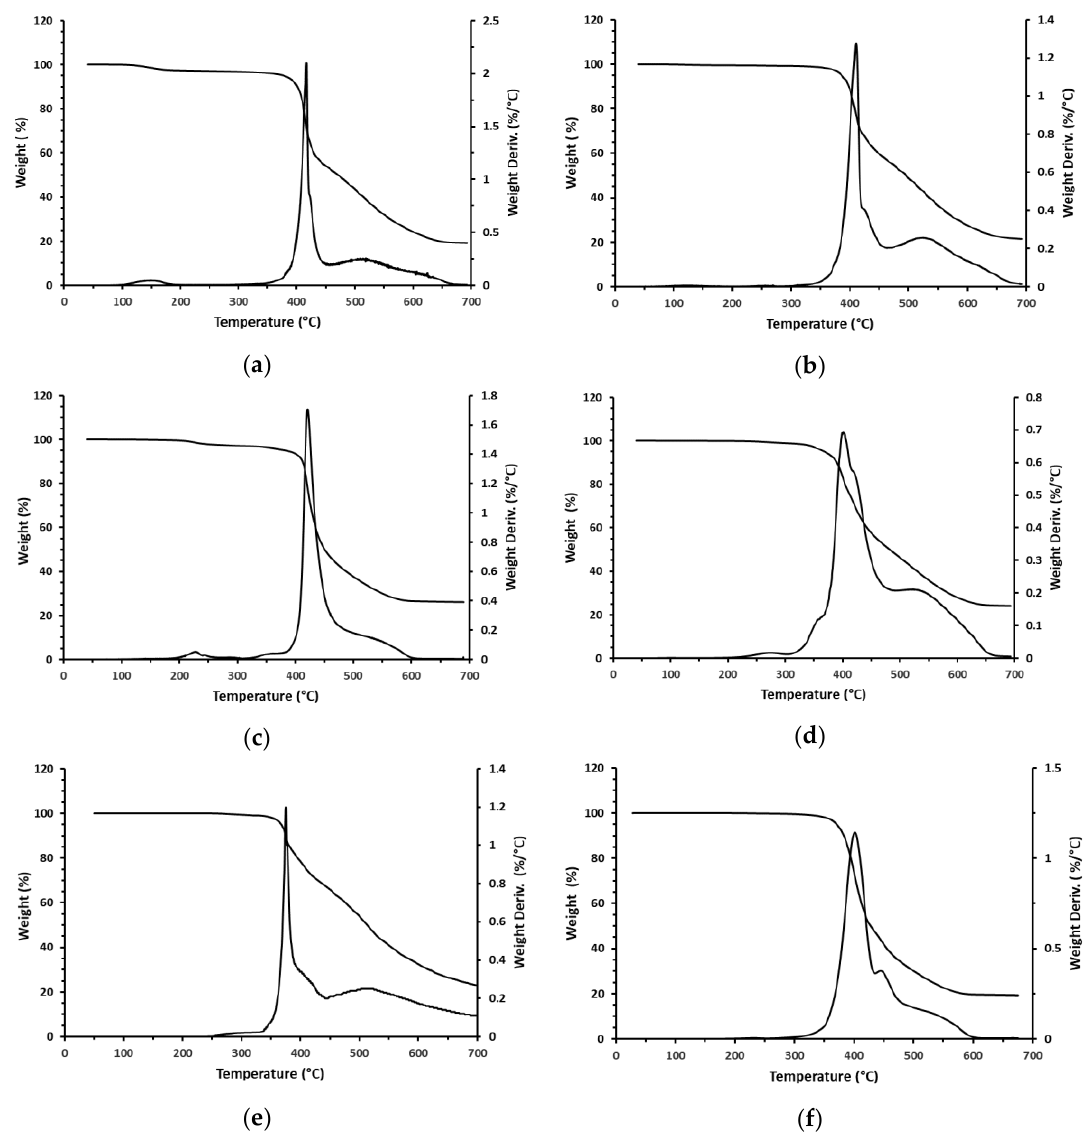
Figure 7. Thermogravimetric weight loss (TGA) and the rate of weight loss (DTG) of brominated flame retardants. ( a ) T-PBBB; ( b ) DBE-PBBB; ( c ) T-PBBB-TBXDP; ( d ) DPE-PBBB-TBXDP; ( e ) PPE-PBBB; ( f ) PS-PBBB.